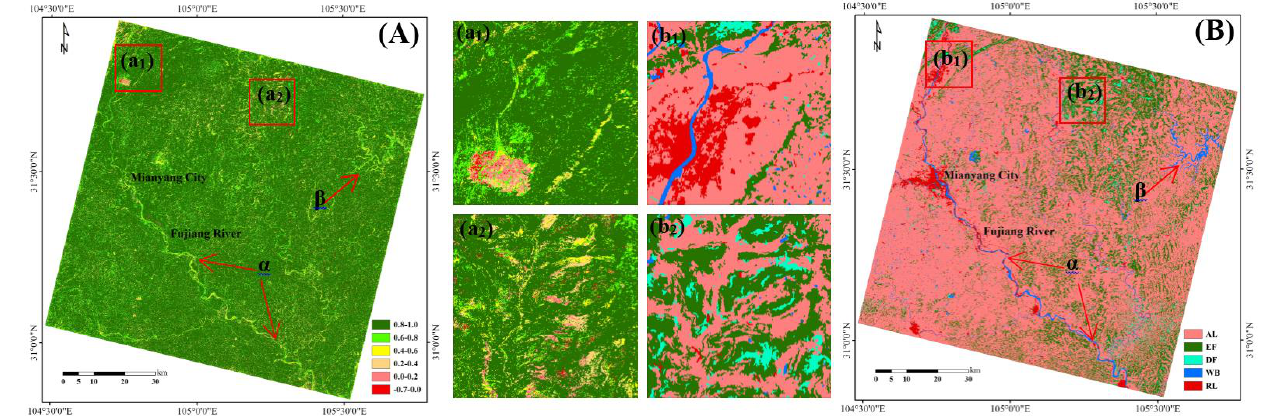
Figure 7. The spatial map of R between two HTSNs synthesized by two different schemes, ( A ) for the spatial map of R and ( B ) for the land cover map. The legend in (B) is same as that in Figure